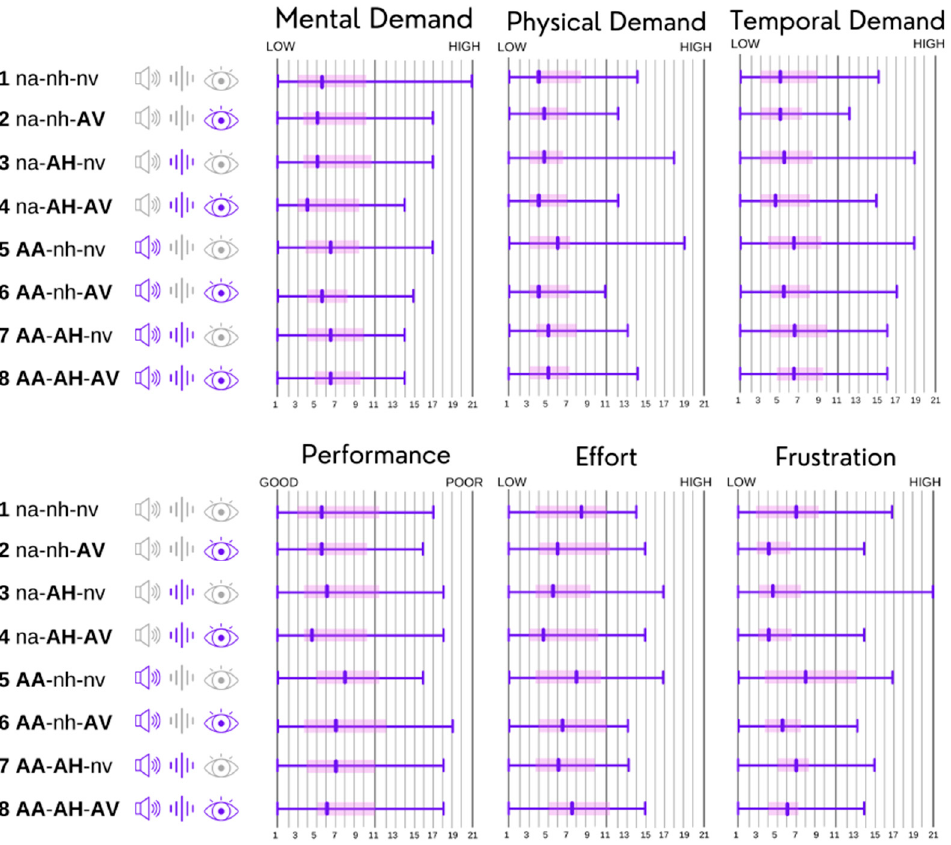
Figure 6. NASA-TLX results: the distribution of responses in all eight conditions.